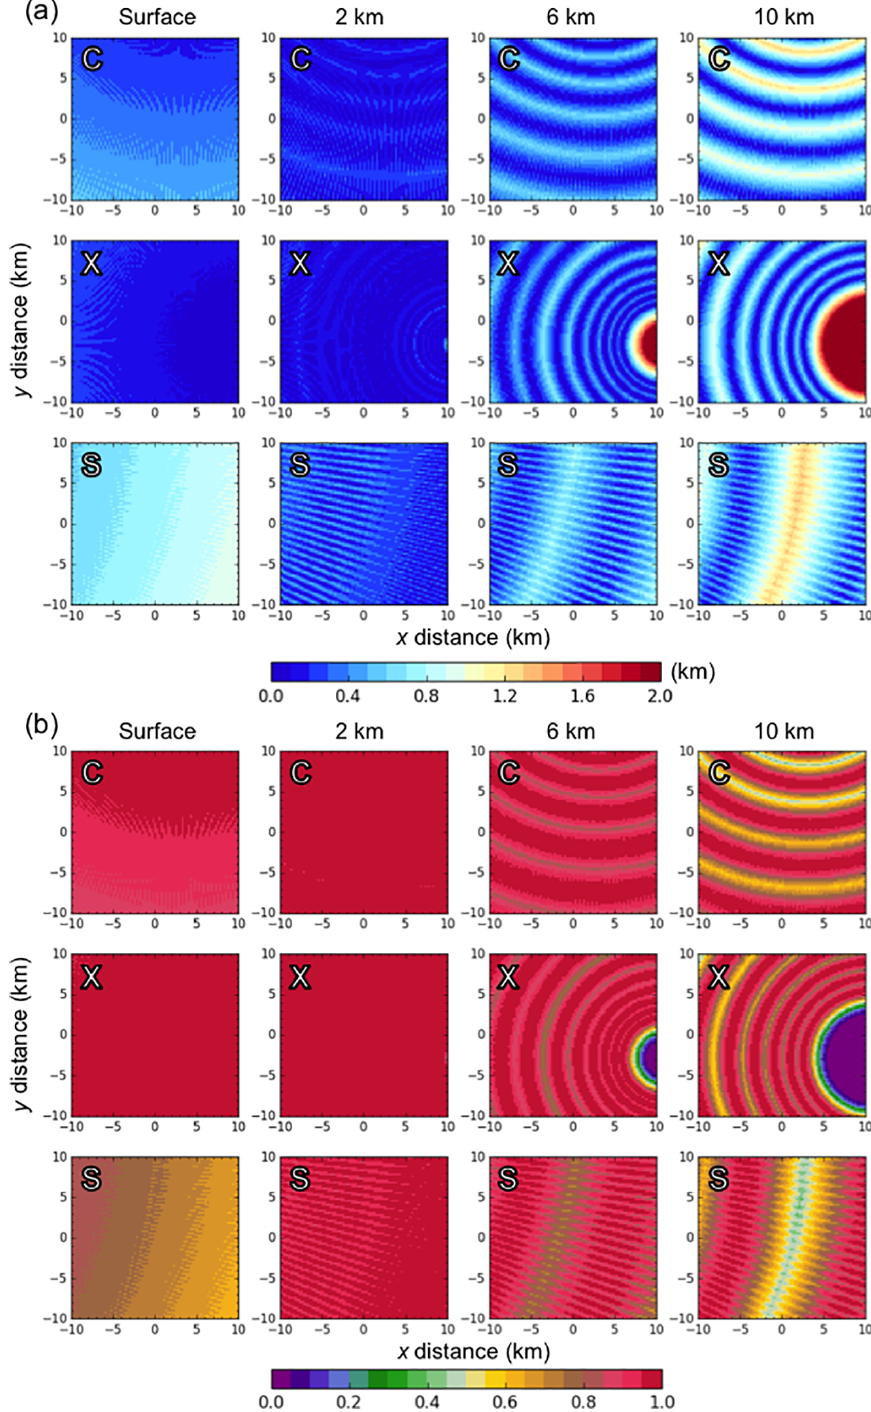
Figure 2. Horizontal distributions of (a) nearest-neighbor distances and (b) nearest-neighbor weights within 20km × 20km surrounding the SGP CF for CSAPR-I7 (C), XSAPR-I4 (X), and KVNX (S) at 0km (surface), 2km, 6km, and